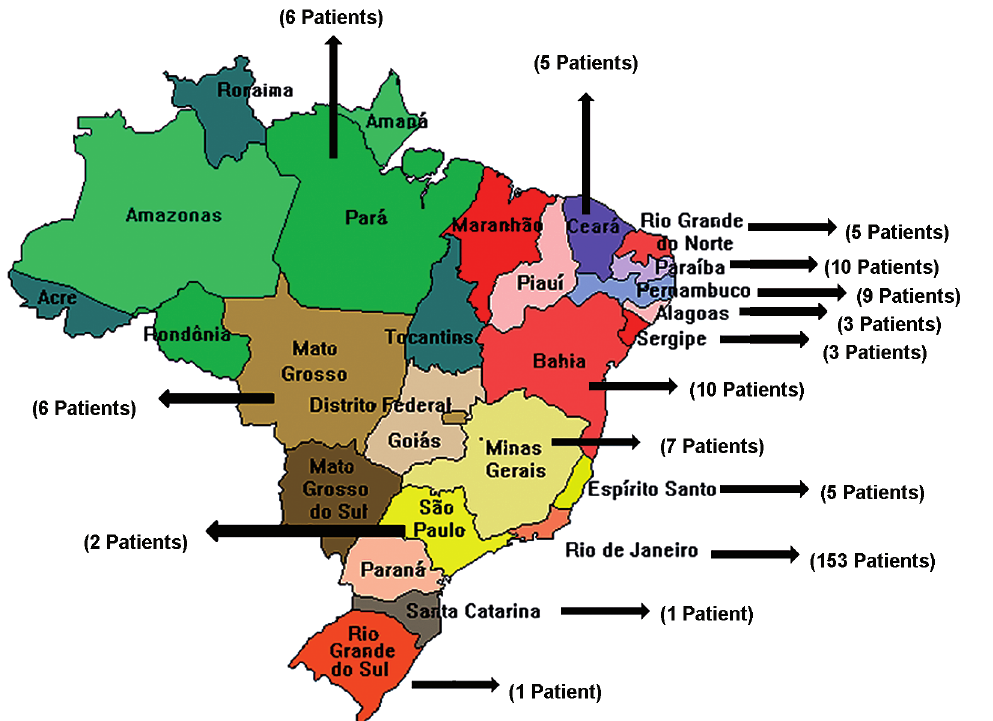
Figure 2 – Geographical distribution by state of birth of patients with tumor of the penis treated in Rio de Janeiro (the total number of patients was lower than 230 cases since 4 patients were